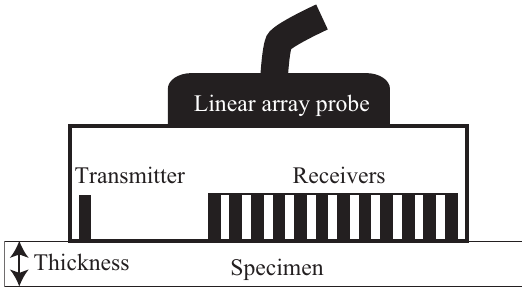
Figure 1. System model used in this study. In this study, we used a 4-mm-thick copper (homogeneous isotropic) plate and a 4-mm-thick bone mimicking (transversely isotropic)